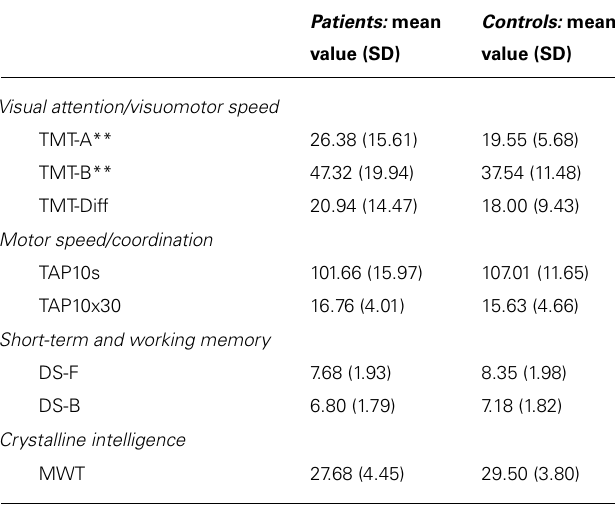
Table 5 | Mean values and SD of the neuropsychological tests of all participants.